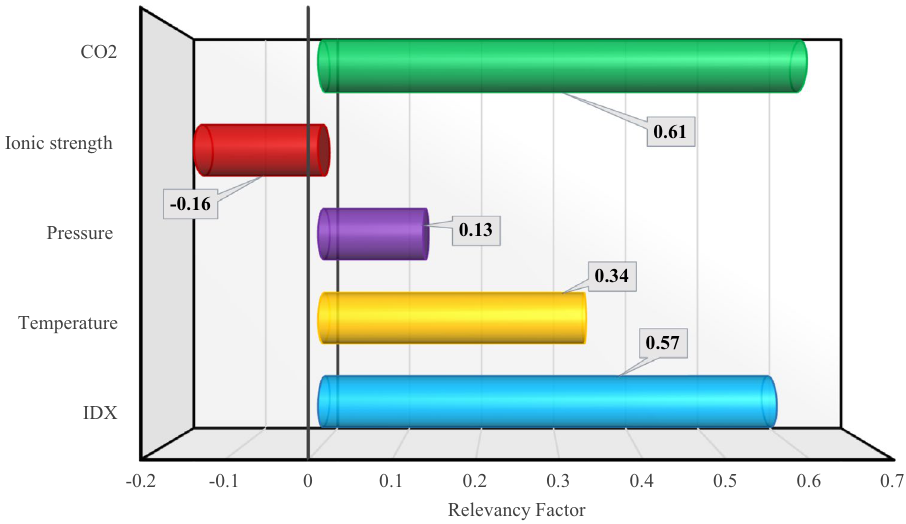
Figure 11. Evaluation of the input parameters’ impact.